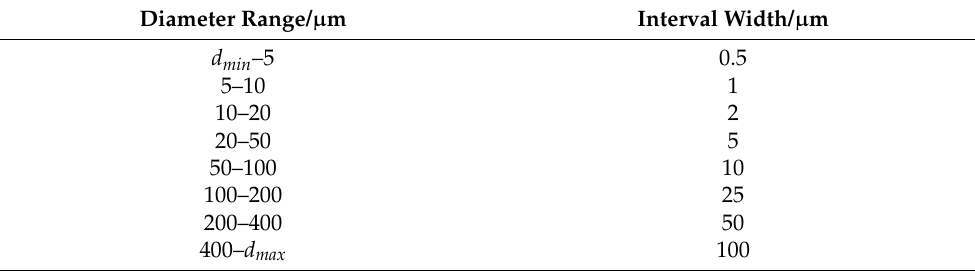
Table 4. Size classes used for the calculation of the pore size